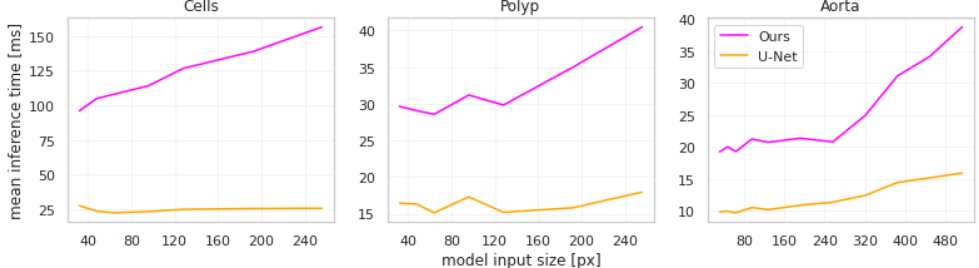
Figure 5. Mean per-input inference time across different input sizes for the U-Net-based